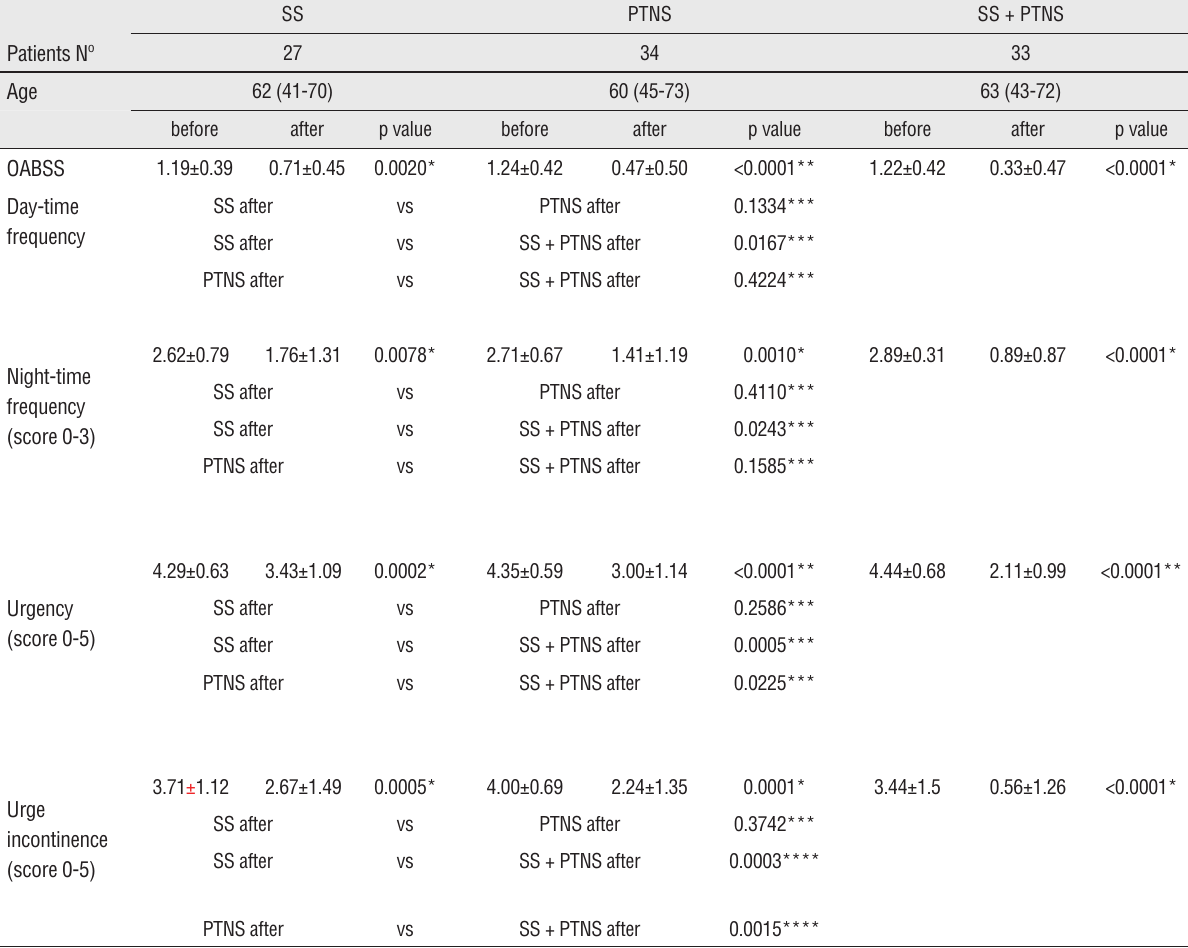
Table 1 - OAB symptoms assessed with OABss questionnaire in patients treated with solifenacin (ss), Percutaneous Tibial nerve stimulation (PTns) and solifenacin + Percutaneous Tibial nerve stimulation (ss + PTns) at the end of treatment. SS